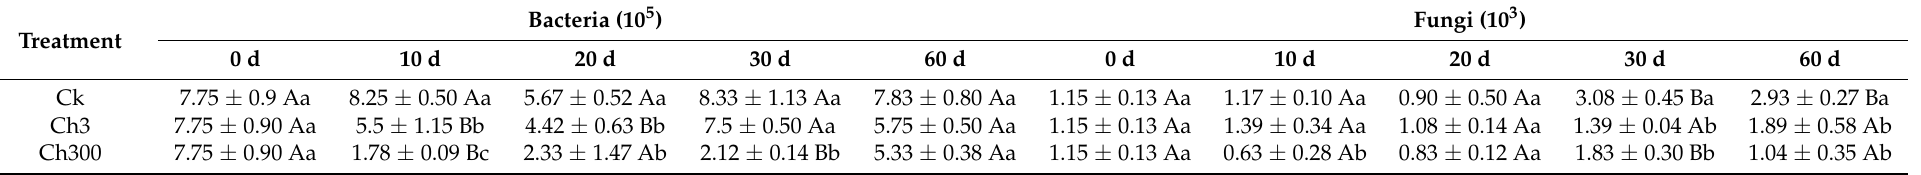
Table 2. Abundance of culturable microorganisms in soil treated with